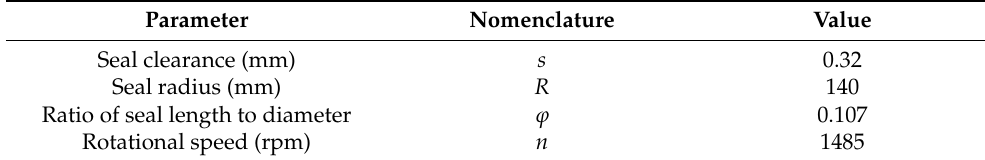
Table 1. Seal geometry of the 1400-MW canned nuclear coolant pump scale hydraulic model [27].